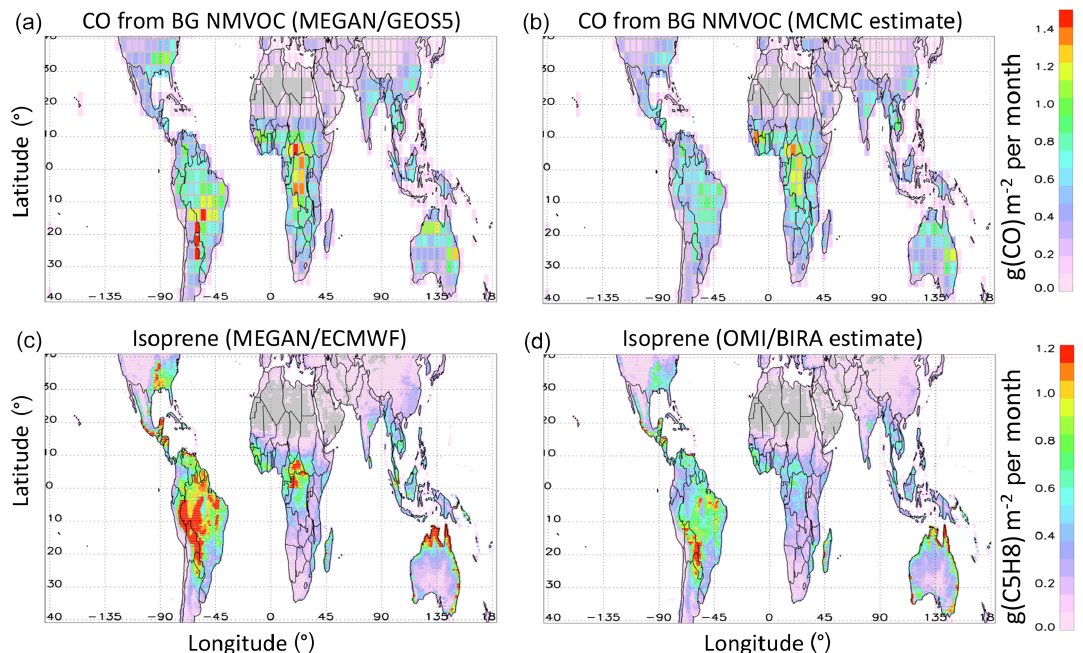
Figure 1. 2005–2012 average biogenic flux for CO (a, b) and isoprene (c, d) with model estimates using MEGAN on the left and top-down estimates using MOPITT observations for CO (b) and isoprene inferred from OMI HCHO observations (d)